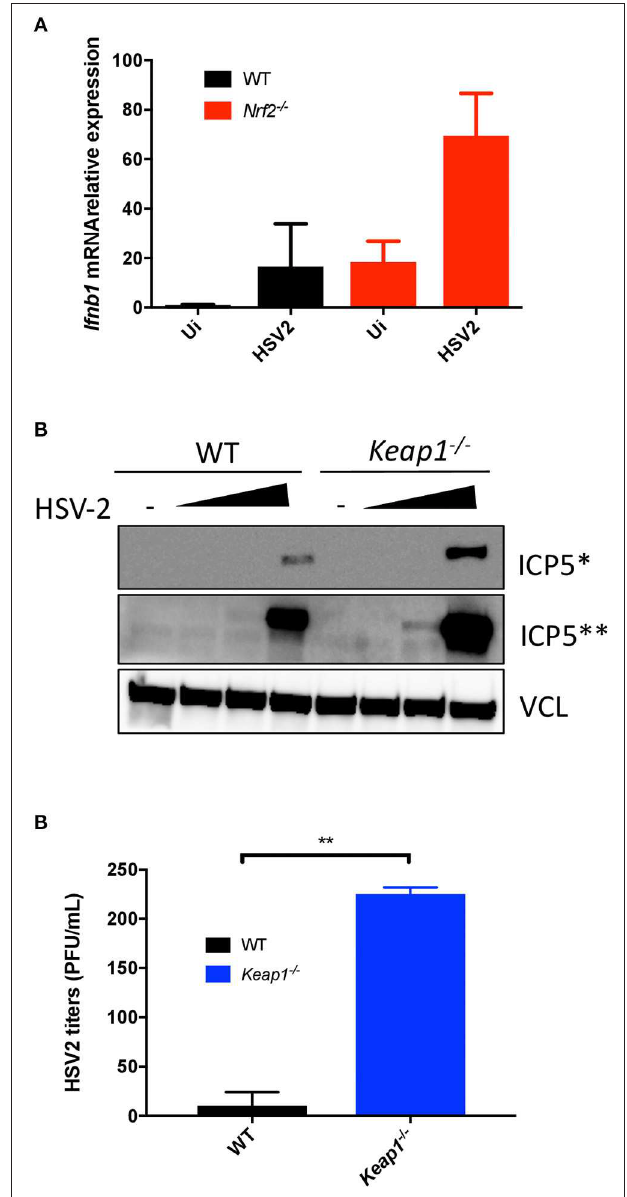
FIGURE 4 | Nrf2 increases the susceptibility to HSV-2 infection in vitro . (A) WT and Nrf2 KO peritoneal macrophages were infected with HSV-2, MS strain for 6h and mRNA level of Ifn β 1 was detected by qPCR. (B) WT and Keap1 KO MEFs were infected with HSV-2, MS strain (MOI 0.01, 0.1 and 1, titer 1 × 10 8 PFU/mL) for ∼ 24h. ICP5 Viral protein expression was detected by immunoblotting and vinculin (VCL) was used as a loading control. (C) The supernatants from samples in (B) were used for plaque assay to determine viral replication. The plaque assay was performed on duplicated samples at an MOI of